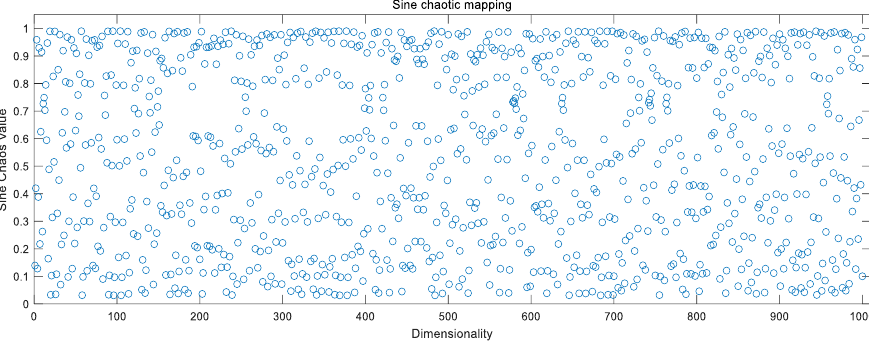
Figure 3. Logistic chaotic mapping values. Figure 4. Tent chaotic mapping values. 3.4. Improved Sparrow Search Algorithm Based on Chaotic Mapping Applying chaos mapping to SSA increases the uniformity of the initial solution dis- tribution, improves the efficiency and traversal uniformity of the optimal search, im- proves the population search capability, and, to some extent, overcomes the shortcomings of the population intelligence algorithm, such as the reduction of population diversity when approaching the optimal solution, the tendency to fall into local optimum, and the reduction of search accuracy. The flow chart is shown in Figure 5. The algorithm flow is as follows: •